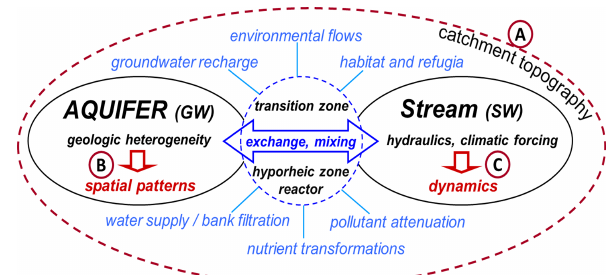
Figure 5. Conceptual depiction of the GW–SW interface and the nested controls of spatio-temporal patterns of exchange and solute turnover in the transition zone between GW and SW (using a river– aquifer system as an example). (a) Primary spatial controls defined by regional topography and geology, (b) secondary spatial controls defined by local aquifer and stream bed geologic heterogeneities as well as streambed morphology, and (c) temporal controls caused by river flow dynamics. Processes and management aspects that are affected by these exchange and turnover patterns are shown in light